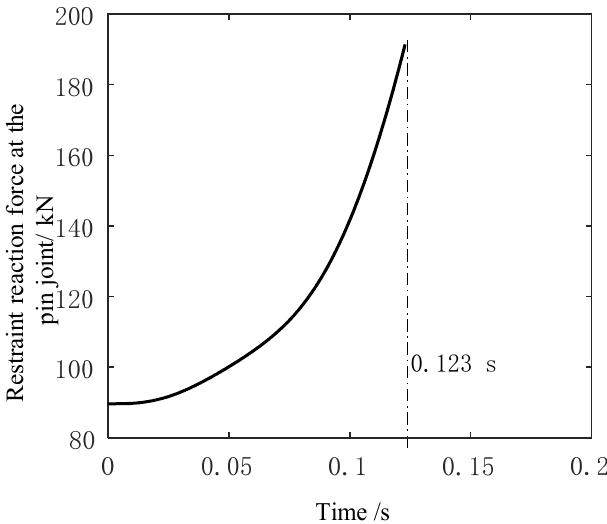
Figure 8. Time versus restraint reaction force at the pin joint.